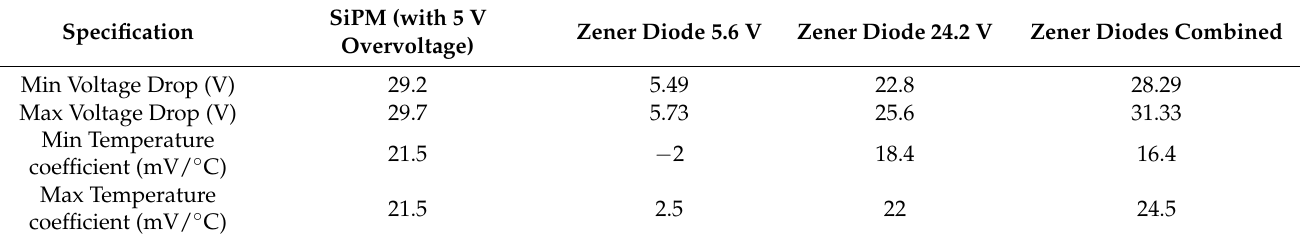
Table 1. Tolerances for voltage drop and temperature coefficients